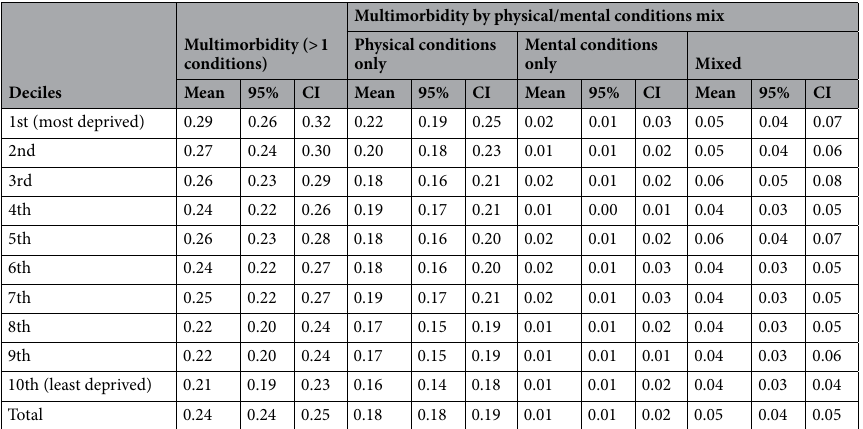
Table 3. Multimorbidity by deciles of Index of Multiple Deprivation (IMD 2019). Population estimates for England and Wales. Standard errors adjusted for clustering and stratification. Number of observations in each model: 24,520. Source: Understanding Society (2020), Wave 10, linked with ONSPD (Nov 2020) and Index of Multiple Deprivation (2019) at the LSOA 2011 level.